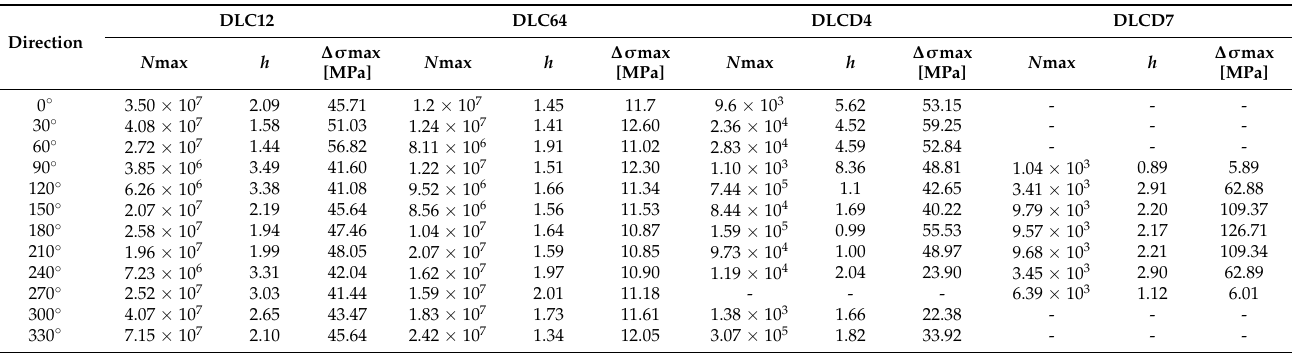
Table 1. Weibull parameter of the fitted